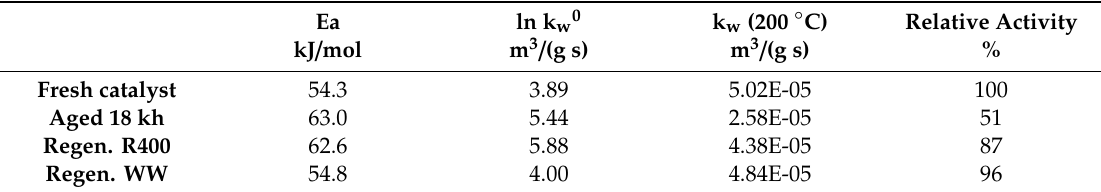
Figure 9. NO ( a ) and NH 3 ( b ) conversion and N 2 selectivity ( c ) as a function of the reaction temperature during the NH 3 -SCR tests on fresh, aged, and regenerated (R400 and WW) catalyst; ( d )) Arrhenius plots showing the corresponding values of the NO reaction rate constant as a function of inverse temperature. Table 5. Kinetic parameters E a and k w0 , values of the kinetic constant and relative activity at 200 °C for fresh, aged, and regenerated catalysts.